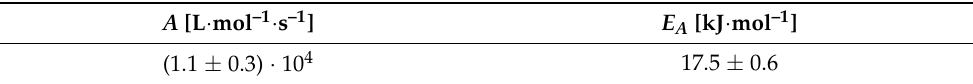
Table 3. Experimental Arrhenius parameters for chain-length-averaged k p of DEI, obtained via PLP-SEC.